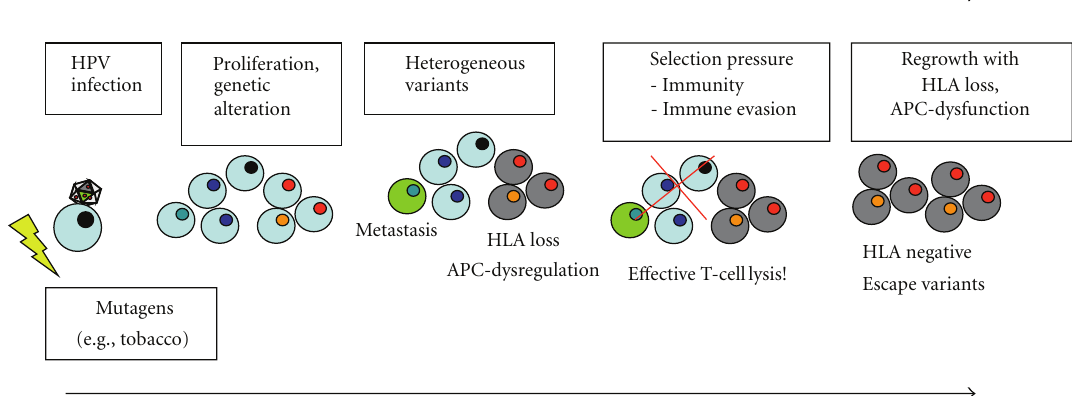
Figure 1: Immune escape variants of cells in the tumor indicate an e ff ective T cell response. HPV infection leads to unregulated cell proliferation and accumulation of chromosomal aberration. Cumulative genetic alterations in tumor cell subclones lead to the emergence of tumor cell variants with divergent characteristics, for example, loss of HLA expression. Selection pressure is exerted by the microenvironment of the tumor and immune response mechanisms. Over time, susceptible cells will be eliminated and resistant cells will regrow, to form a tumor consisting of predominantly immunoresistant cells and compromising immunotherapeutic